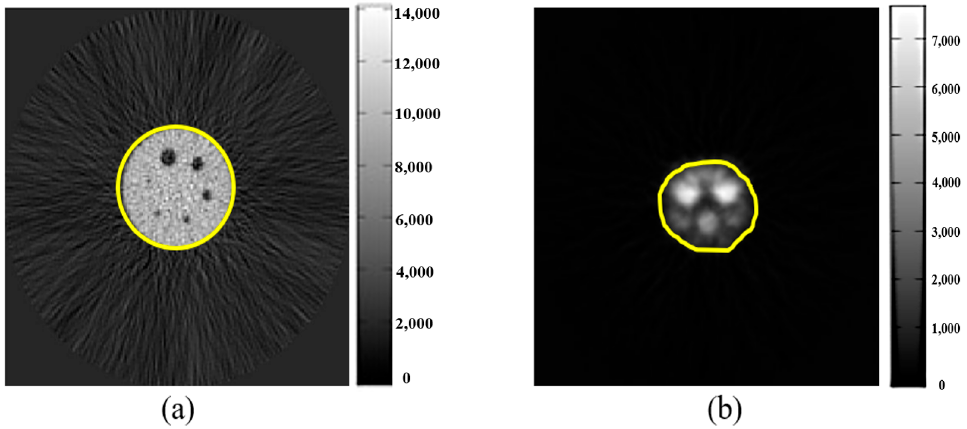
Figure 5. ROI method to determine the background of Deluxe Jaszczak phantom ( a ) and rat image ( b ), calculating their background standard deviation to assess image background denoising merits after MSO noise processing.